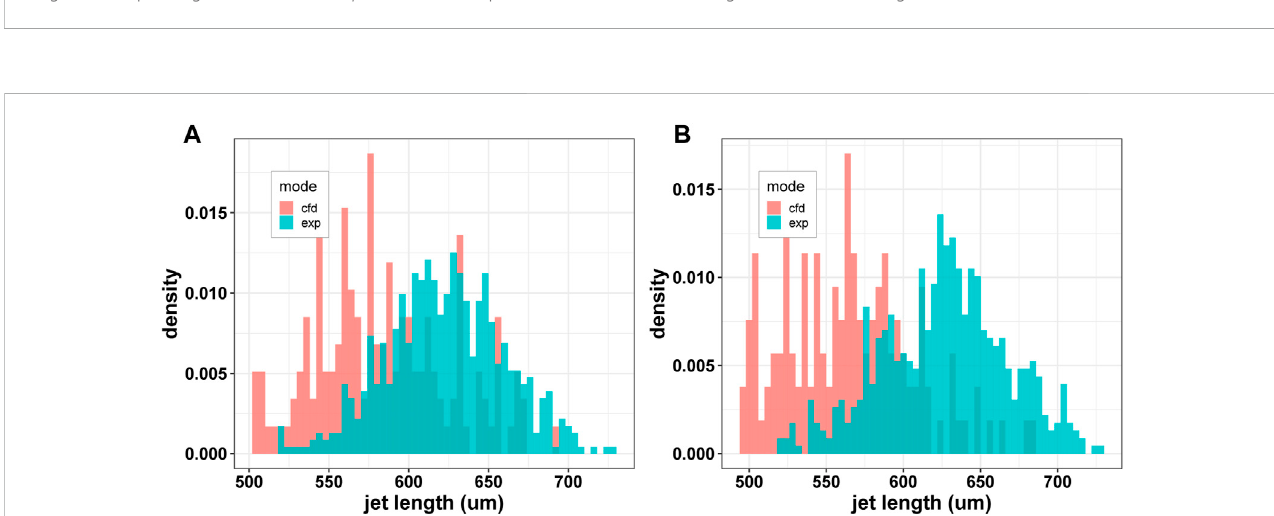
FIGURE 15 ExperimentalandCFDresultsofthebell-shapednozzles (A) andexperimentalandCFDresultsofthecone-shapednozzles (B) .Theoperatingconditions are 48 μ L/min for the liquid (water) fl ow rate and 6 mg/min for the sheath gas fl ow